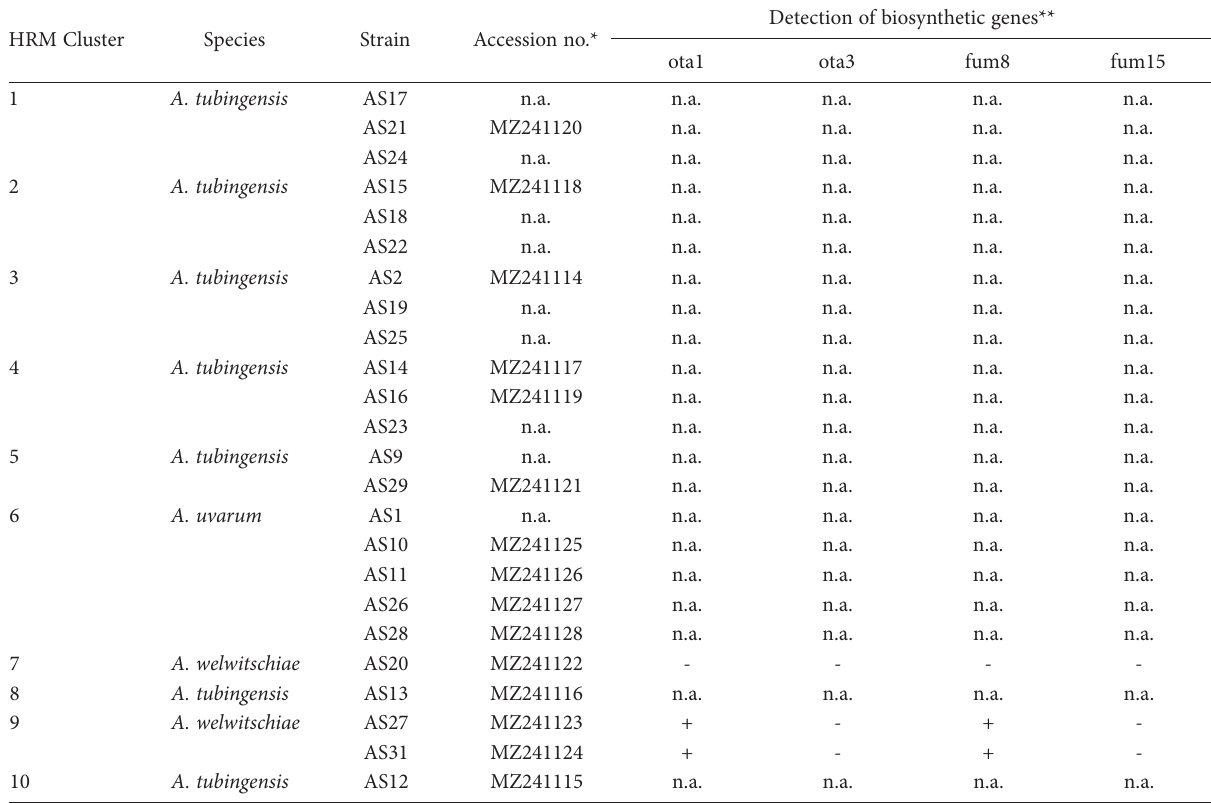
Table 4. Aspergillus HRM clusters, species, strains, GenBank accession numbers for the calmodulin gene, and presence of ochratoxin A ( ota1 and ota3 ) and fumonisins ( fum8 and fum15 ) biosynthetic genes.